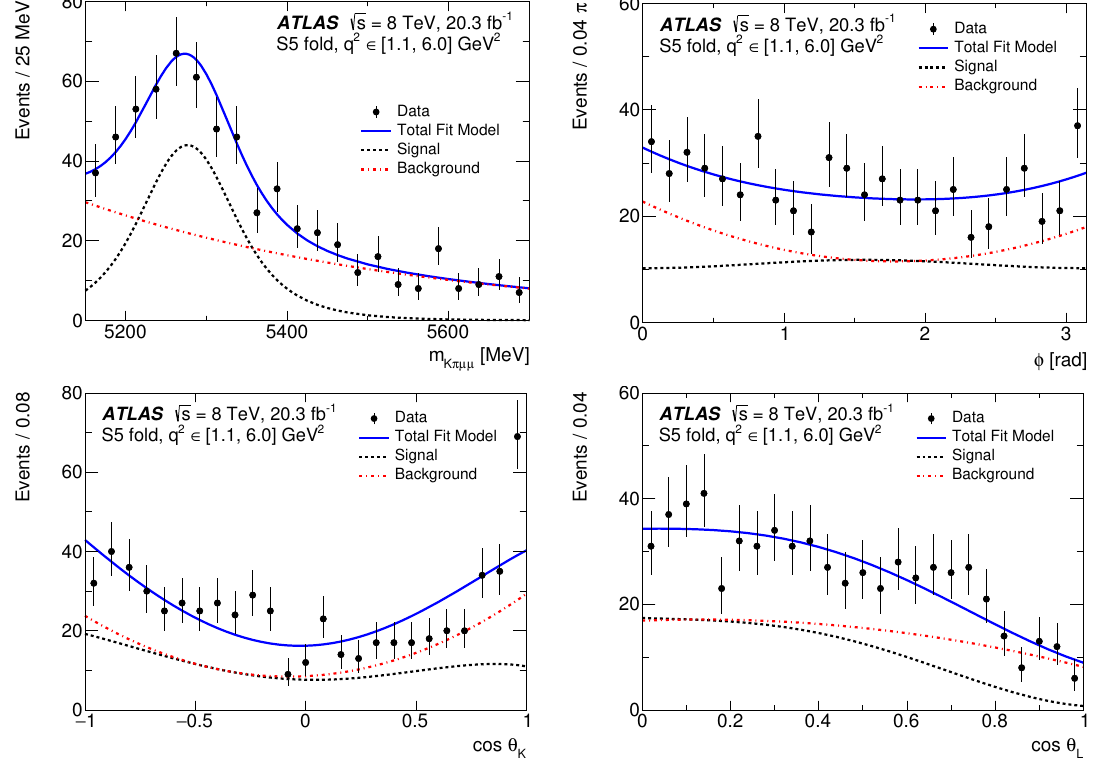
Figure 8 . The distributions of (top left) m , (top right) (cid:30) , (bottom left) cos (cid:18) , and (bottom K(cid:25)(cid:22)(cid:22) K right) cos (cid:18) obtained for q 2 2 [1 : 1 ; 6 : 0] GeV 2 . The (blue) solid line is a projection of the total pdf, L the (red) dot-dashed line represents the background, and the (black) dashed line represents the signal component. These plots are obtained from a (cid:12)t using the S folding 5